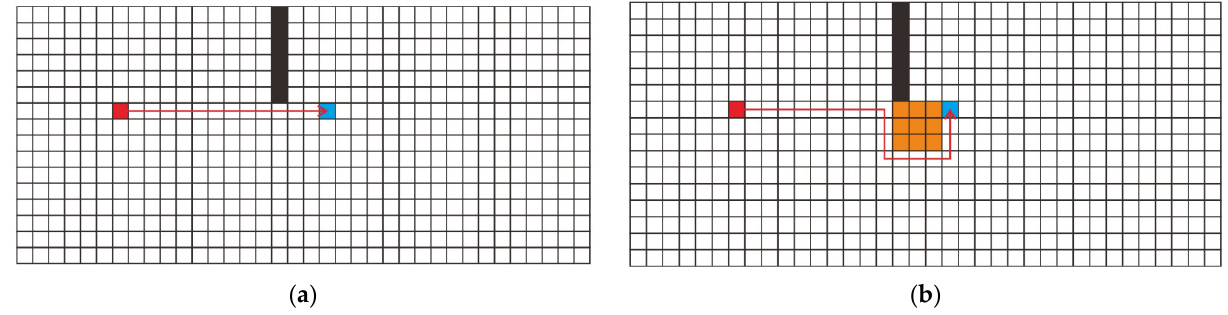
Figure 5. The comparison between ordinary planning and time-varying planning. ( a ) Spacetime latitude is not considered; ( b ) consider spacetime